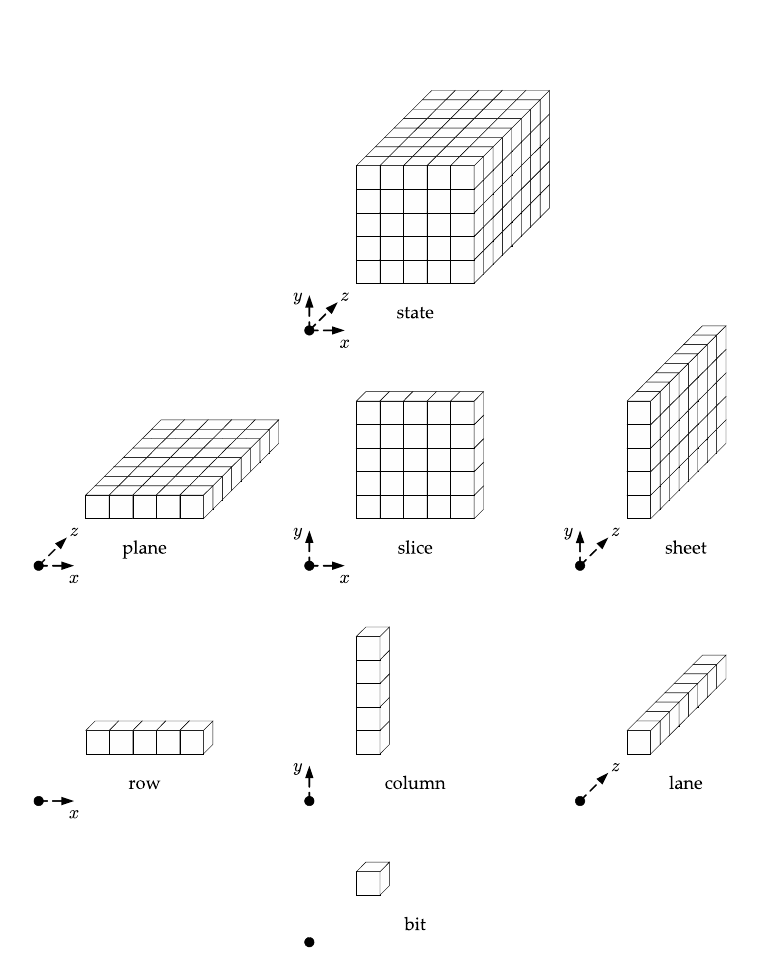
Figure 5: The Keccak state (taken from